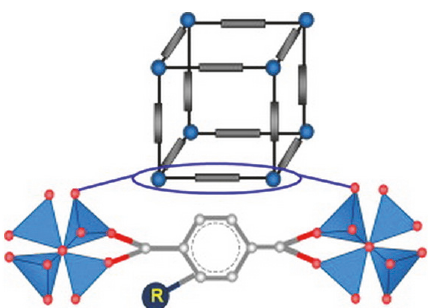
Figure 7: Organic metal frame structure.